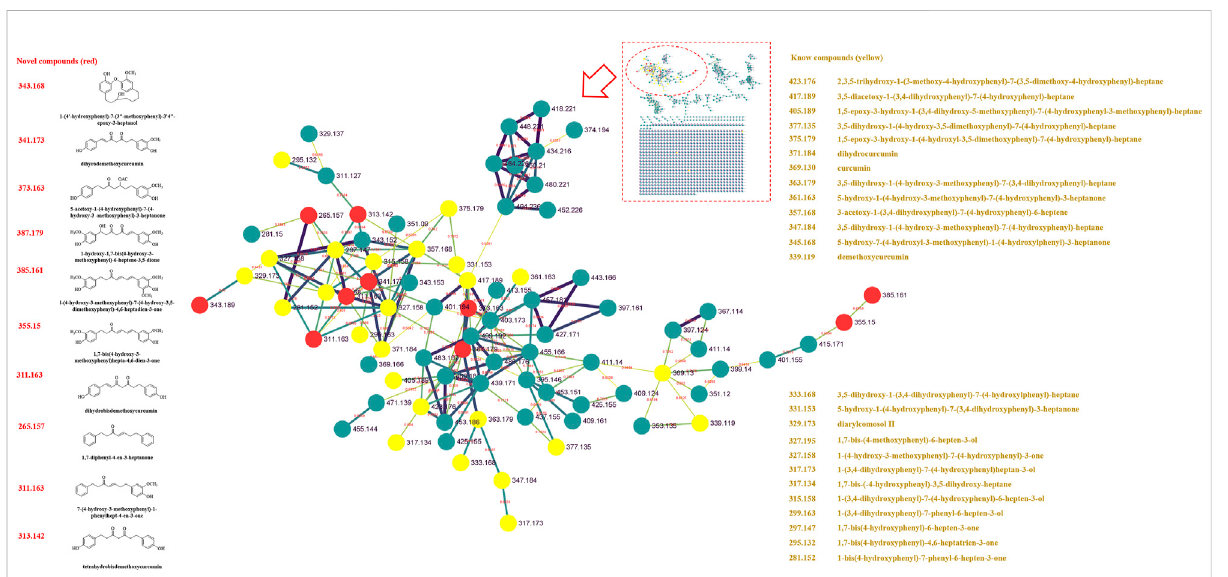
FIGURE 2 MS/MS molecular networking of the CR-SR decoction in the positive mode. The novel compound is in red, and its name and structure are depicted in the left column. The known compound is in yellow, and the name is depicted in the right column.